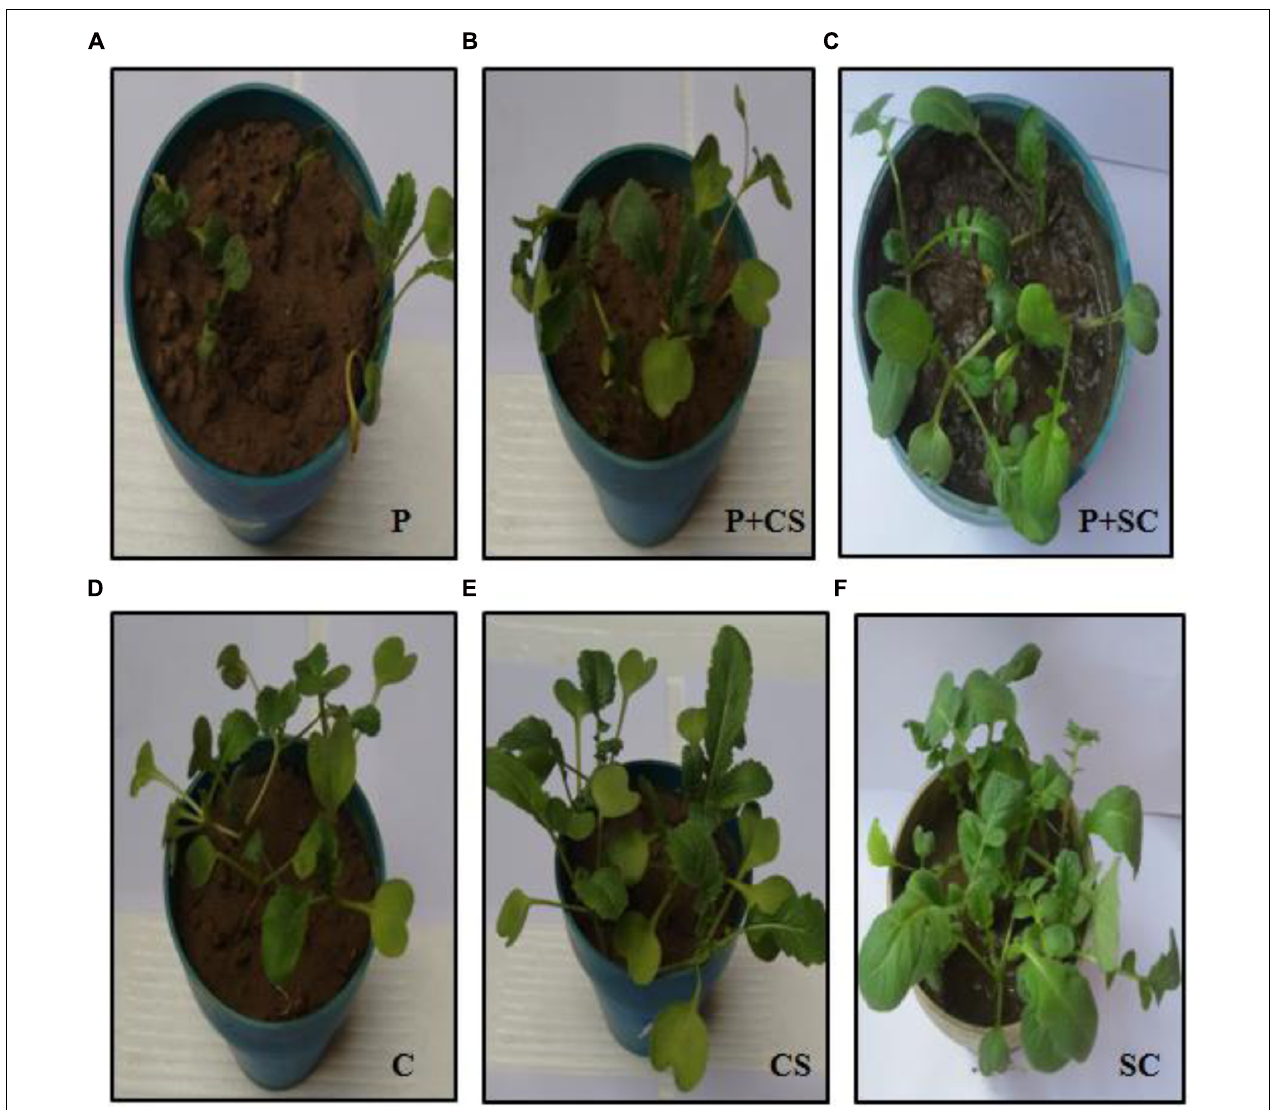
FIGURE 5 | In vivo protective effects of S. hydrogenans DH16 as seed dressing on radish seeds artificially treated with fungal pathogen ( A. brassicicola ). Growth of the radish plants (from left to right) after treatment of seeds with (A) pathogen (B) pathogen and Streptomyces cells (C) pathogen and extract (D) water (E) Streptomyces extract (F) Cells of Streptomyces